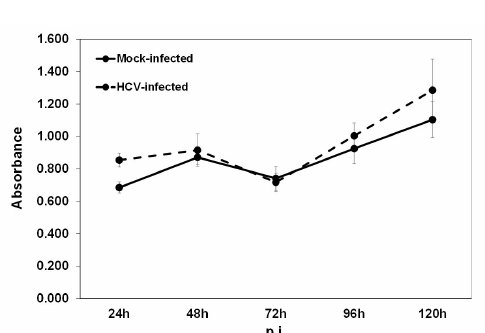
Figure A1. Proliferation assay in early HCV infection. The CellTiter 96 ® Aqueous One Solution Cell Proliferation Assay (Promega) was used to assess proliferation rates of HCV-infected vs. mock- infected Huh7.5 hepatoma cells at the given time points p.i. The test was carried out according to the manufacturer’s instructions, and the absorbance recorded at 490 nm represents cell growth in the absence (dotted line) or presence (continuous line) of HCV. The experiment was carried out twice in triplicate and did not demonstrate significant differences between the HCV- and the mock-infected cell populations with